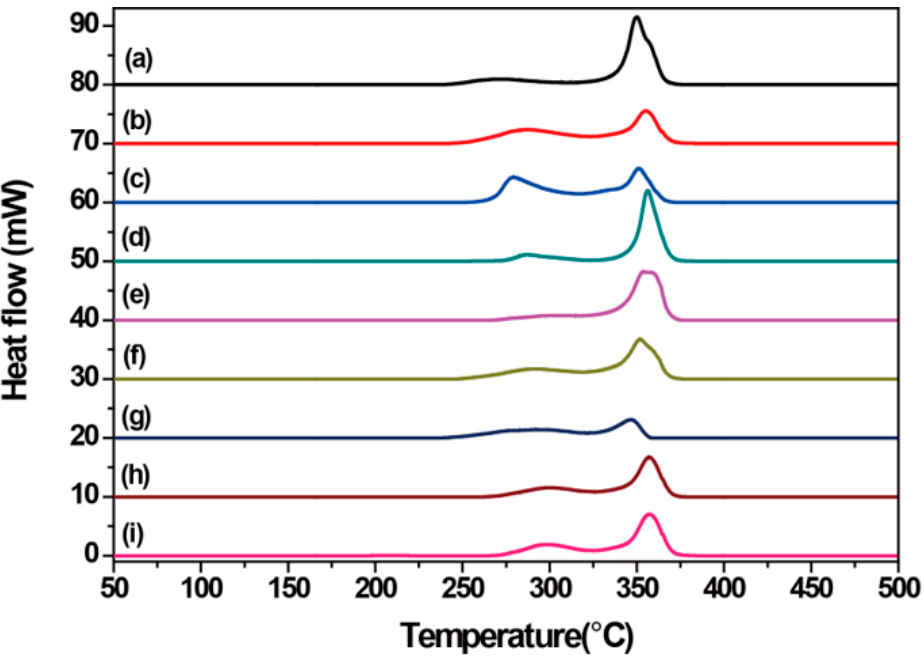
Figure 5. Di ff erential scanning calorimetry (DSC) curves of LLM-105 crystals obtained from di ff erent antisolvents. ( a ) Water, ( b ) methanol, ( c ) acetic acid, ( d ) nitromethane, ( e ) ethyl acetate, ( f ) ethanol, ( g ) methylene chloride, ( h ) o-dichlorobenzene, and ( i ) toluene. Table 1. Thermal analysis of LLM-105 crystals obtained from di ff erent